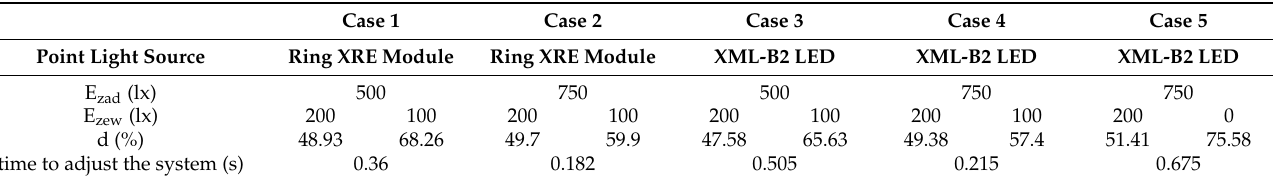
Table 6. Control system response time for different